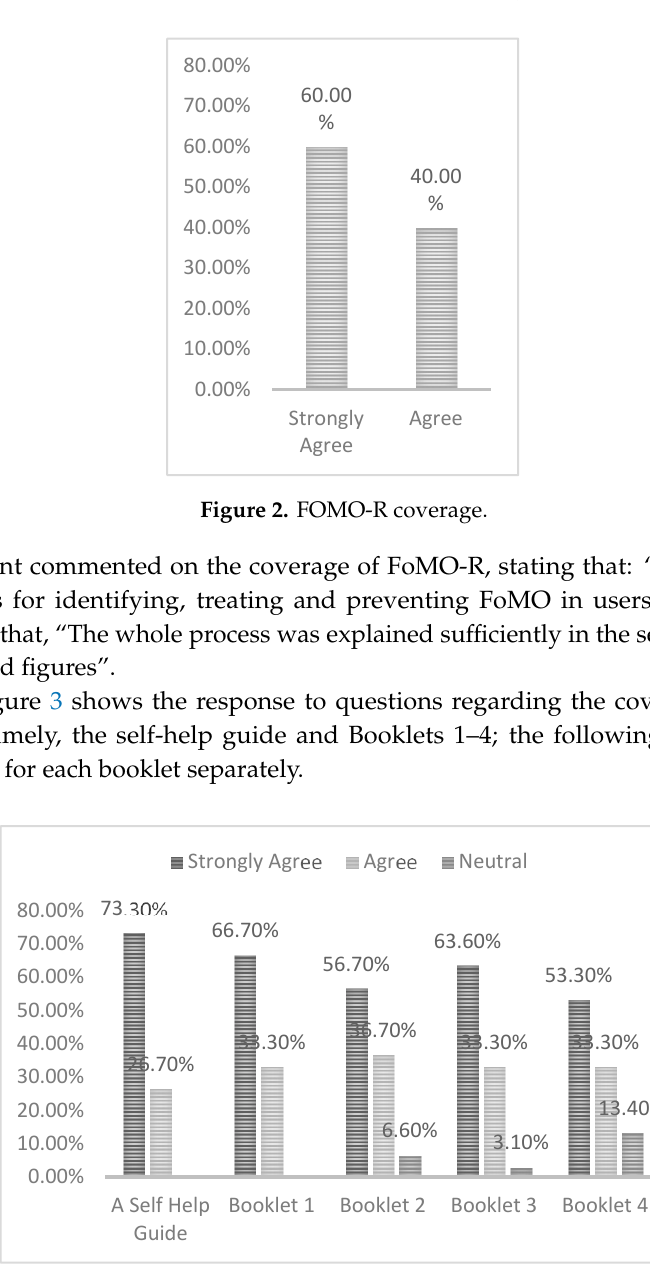
Figure 3. Supplementary materials coverage.